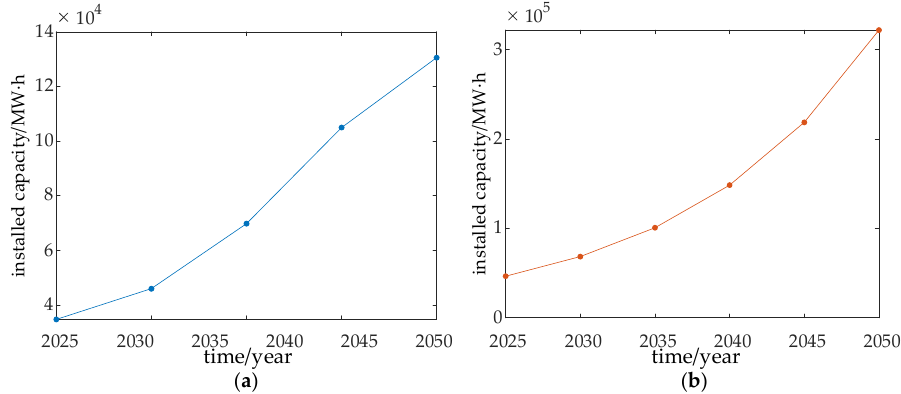
Figure 12. The planning capacity of hydrogen storage tank. ( a ) scenario 2; ( b ) scenario 3.